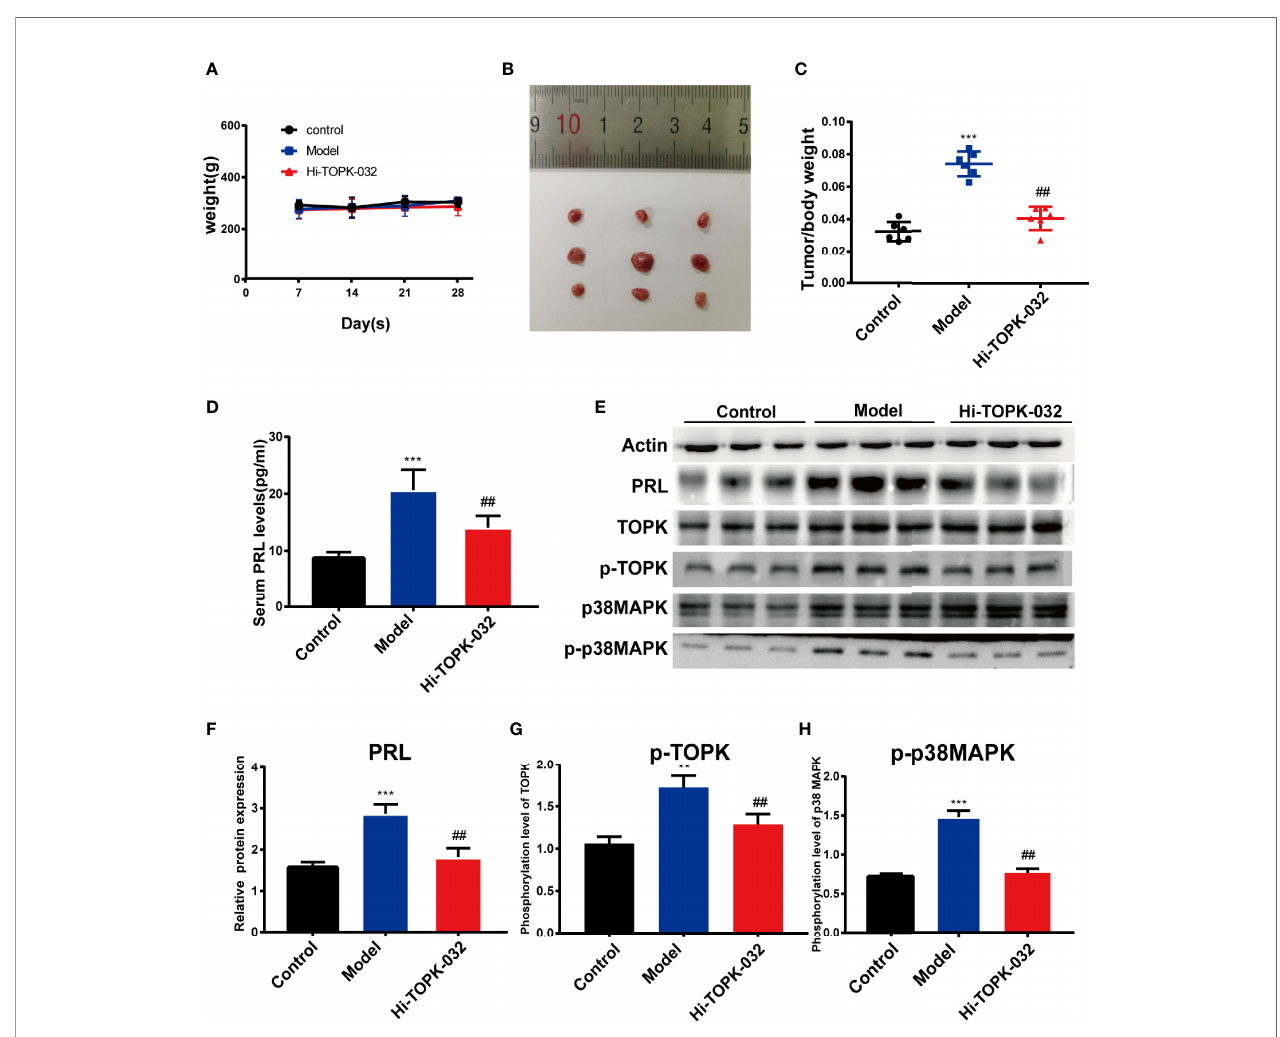
FIGURE 5 | HI-TOPK-032 inhibited tumor growth of prolactinoma and reduced PRL secretion in vivo . (A) The body weight changes of rats in each group were recorded once per week during treatment. (B) Photograph of the pituitary tissues. The fi rst row represents the control group, the second row represents the model group, and the third row represents the HI-TOPK-032 (10mg/kg) treatment group. (C) The ratio of pituitary weight to body weight of control group, model group and Hi-TOPK-032 treatment group. (D) PRL secretion levels in serum of rats in each group were detected by ELISA assay. (E) The protein expressions of PRL, total TOPK, p-TOPK, total p38 MAPK and p-p38 MAPK in pituitary tissues of rats in each group were detected by Western Blot assay. (F) The protein expression of PRL. (G) Phosphorylation level of TOPK. (H) Phosphorylation level of p38 MAPK. **P < 0.01; ***P < 0.001; ## P < 0.01; ** and *** represent comparison with the control group; ## means compared to the model